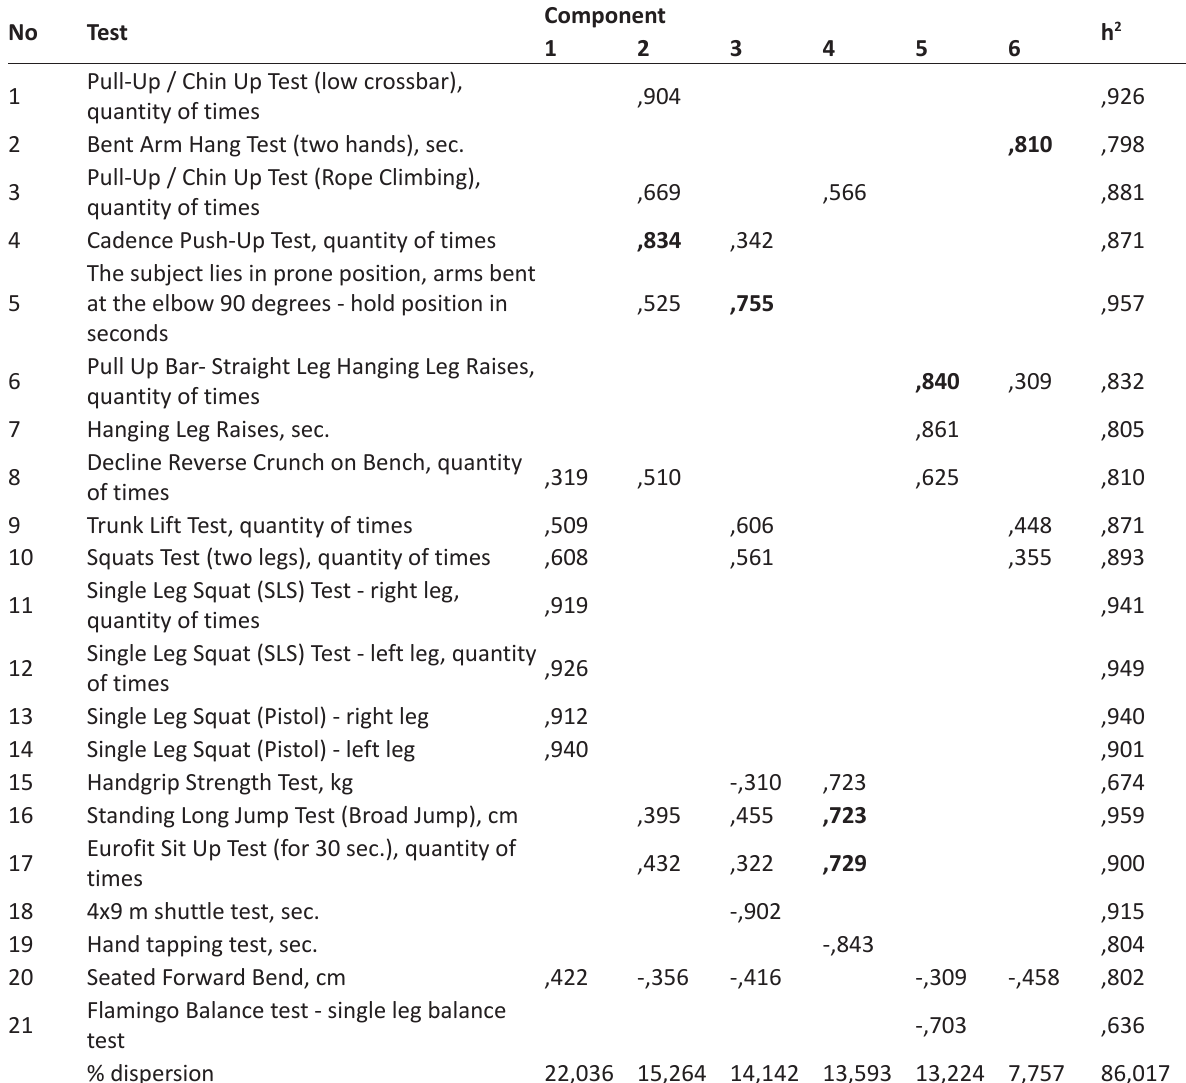
Table 1. Factor structure of motor preparedness of the girls 12 years old. Method: principal component analysis. Rotation method: Varimax with Kaiser Normalization (n = 20)